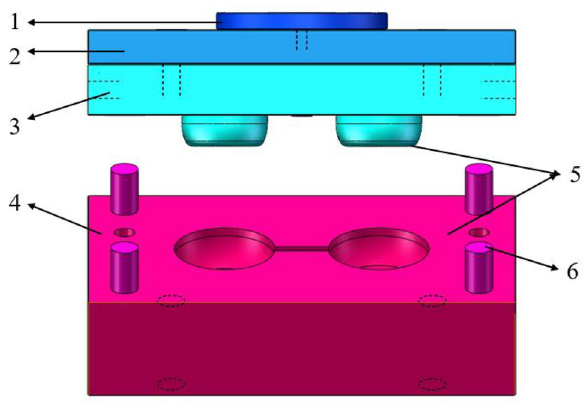
Figure 1. Parting surface of cylinder liner. 1. Positioning ring 2. Fixed template floor 3. Fixed template 4. Dynamic die 5 PS surface 6. guide